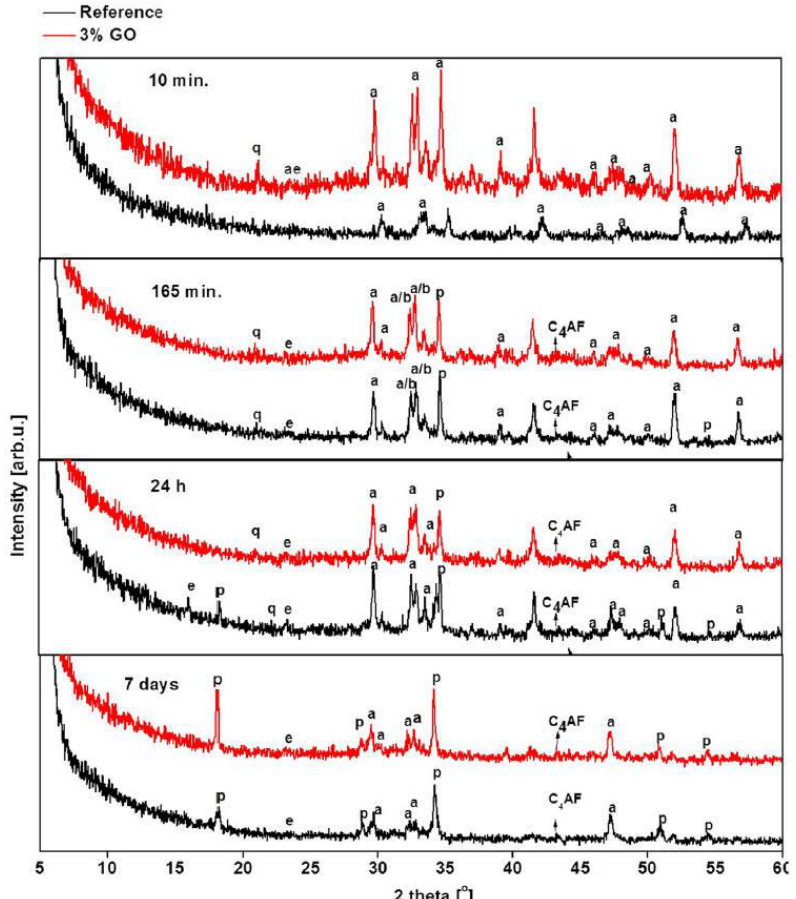
Figure 13. XRD result of plain cement (reference) and GO-reinforced CCMs. Reprinted with permission from Ref. [22]. Copyright 2015 Elsevier.